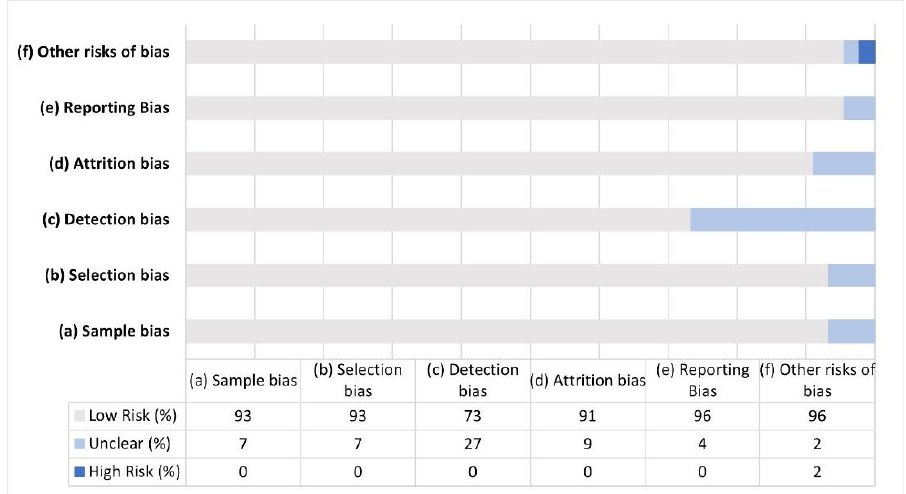
Figure 3. Percentage of risk of bias for each domain of tool assessment for the selected studies.